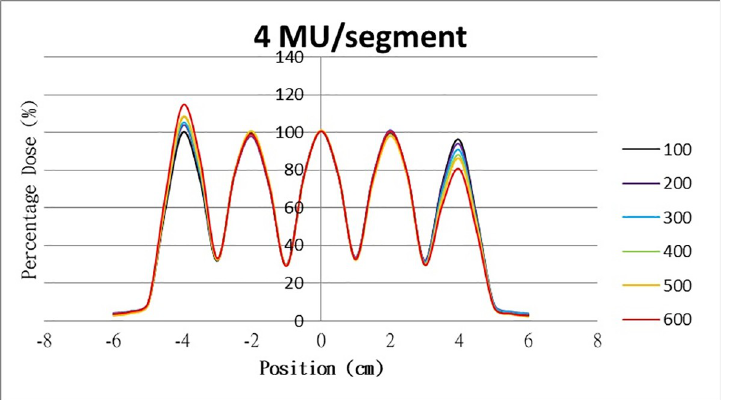
Fig 9. Overshoot effect measured at various MU values and dose rates. Overshoot effect, at various dose rates, for (6) 1 MU, (7) 2 MU, (8) 3 MU, (9) 4 MU, (10) 5 MU, (11) 6 MU, (12) 7 MU, (13) 8 MU, (14) 9 MU, (15) and 10 MU.